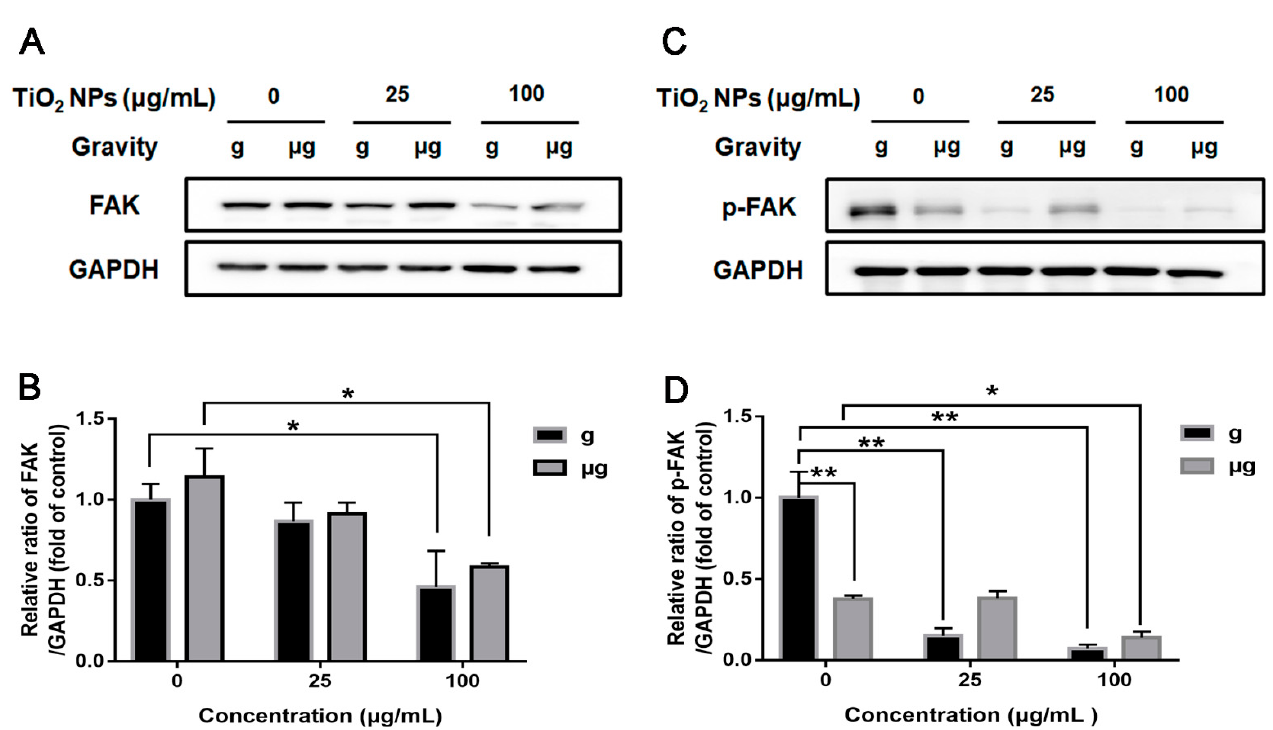
Figure 9. Effect of TiO 2 NPs on the expression levels of FAK and p-FAK (Tyr397). A549 cells were treated with TiO 2 NPs (0, 25 and 100 µ g/mL) for 48 h under normal gravity (g group) or simulated microgravity ( µ g group). Representative results of Western blot analysis showed the protein expressions of FAK ( A ) and p-FAK ( B ) in A549 cells. Quantitative analysis of FAK ( C ) and p-FAK ( D ) were shown. * p < 0.05, ** p < 0.01.